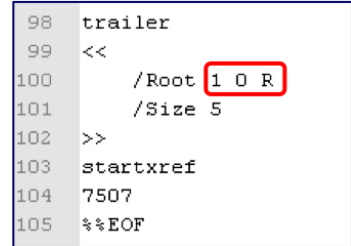
Figure 2. A snapshot of a trailer of PDF.